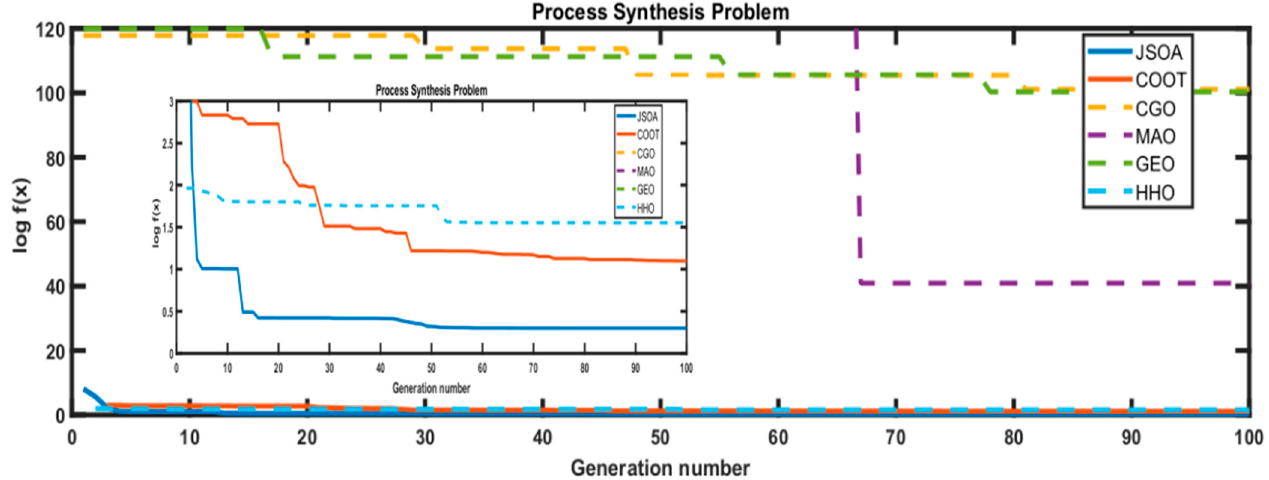
Figure 12. Convergence graph of the Process Synthesis Problem. The dotted line represents an infeasible solution shown by an algorithm. Table 8. Comparison results for the Optimal Design of an Industrial Refrigeration System.